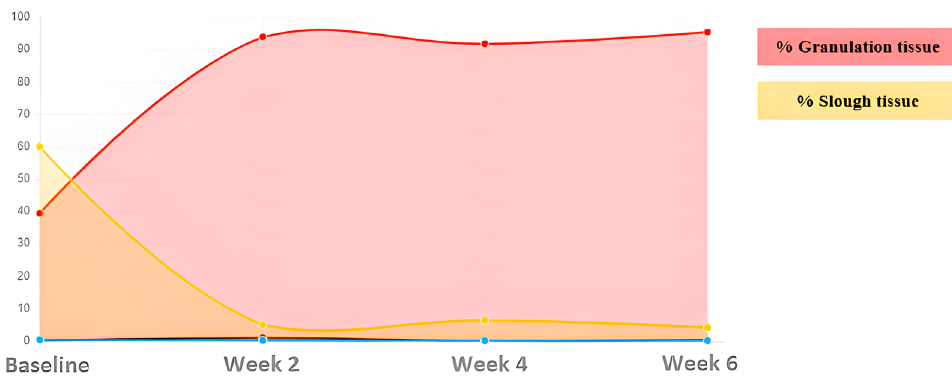
Figure 6. Evolution of tissue types. Case 3.